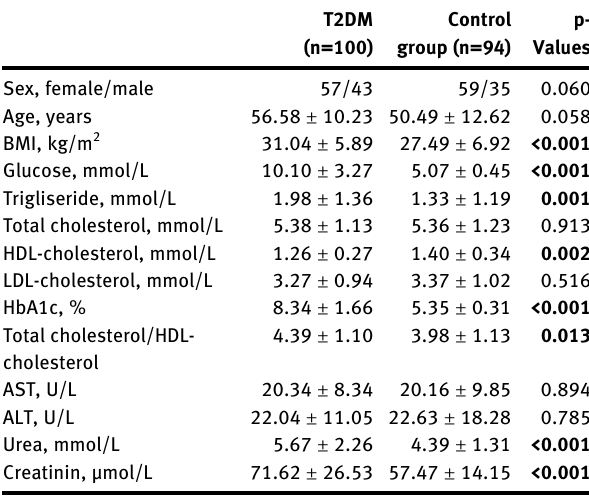
Table  : Demographic characteristic of type  diabetes mellitus patient and control groups.